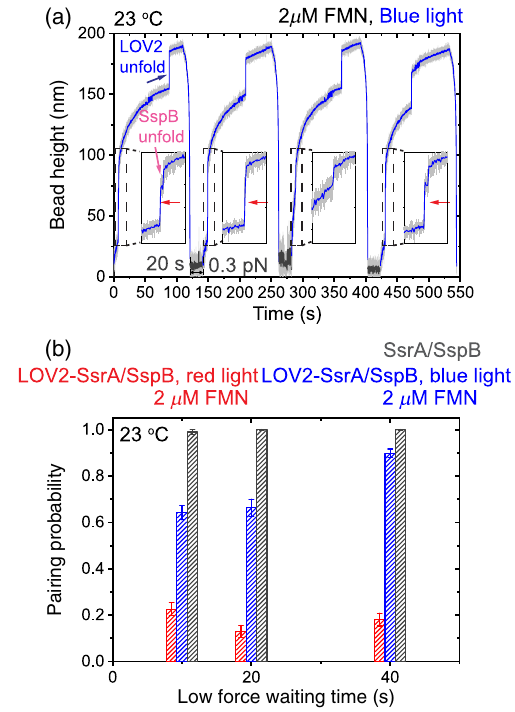
FIG. 5. Autoinhibition strength of LOV2 on the SsrA-SspB interaction. (a) Representative time trace of bead height change during a force-loading assay to probe the effects of the auto- inhibitory strength of the LOV2 domain on the SsrA-SspB interaction. In this example, after holding the LOV2-SsrA/SspB construct at 0.3 pN for 20 s in blue light with 2 μ M FMN, the force is increased at a loading rate of 0 . 5 (cid:1) 0 . 1 pN s − 1 to approximately 60 pN. The LOV2-SsrA/SspB complex is formed in three of four force-loading cycles indicated by unpairing signals in the subsequent force-increase step (red arrows in the enlarged insets). The blue and dark gray lines show a 20-FFT smooth of the raw data (gray). (b) The probabilities of formation of the FMN-LOV2-SsrA/SspB complex with 2 μ M FMN in red light (red) and in blue light (blue) within different holding time intervals at approximately 0.3 pN. The formation probability of the SsrA/SspB complex (gray) is plotted for comparison. For each condition, over 80 force cycles are performed for statistical analysis. The error bars indicate the standard deviation obtained from a bootstrap analysis (Supplemental Material, Sec. S3